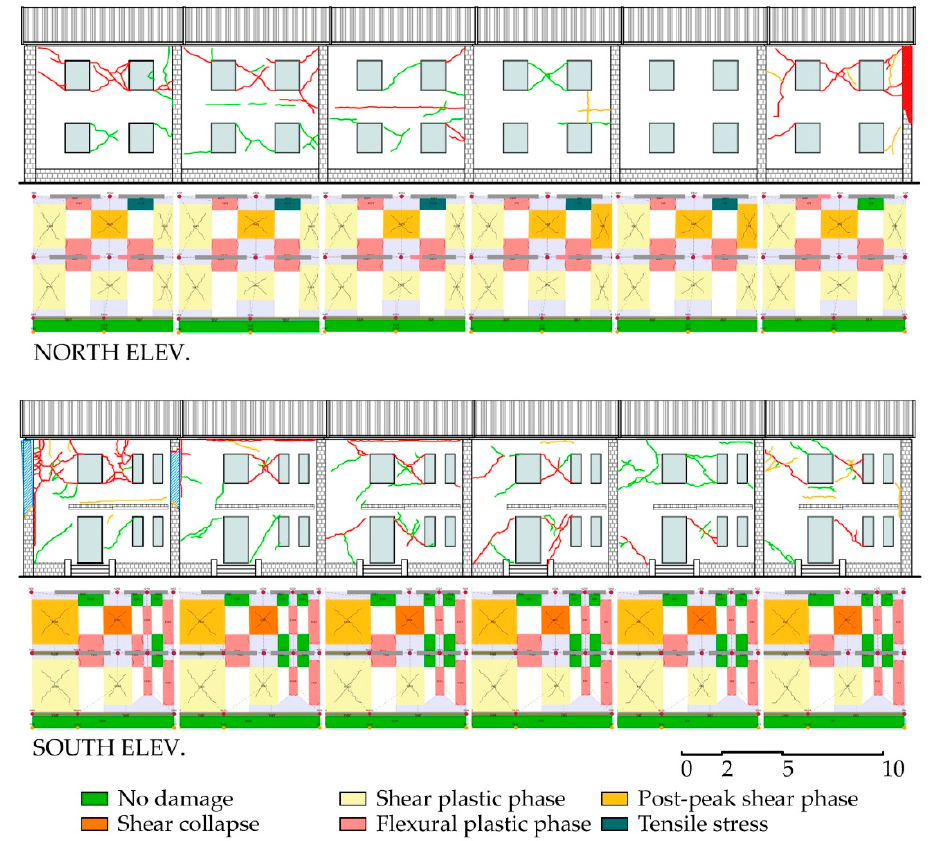
Figure 10. Comparison between damage state obtained from modelling and observed crack pattern. Table 1. Mechanical properties of masonry (values of elastic properties and strength to be reduced to 40% and 70%, respectively, and divided by CF).